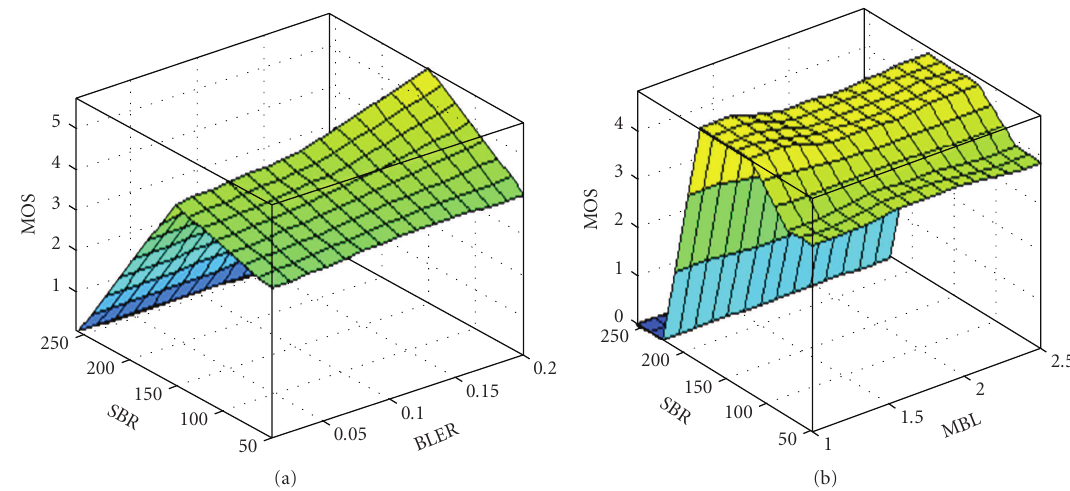
Figure 15: (a) MOS versus SBR versus BLER. (b) MOS versus SBR versus MBL.